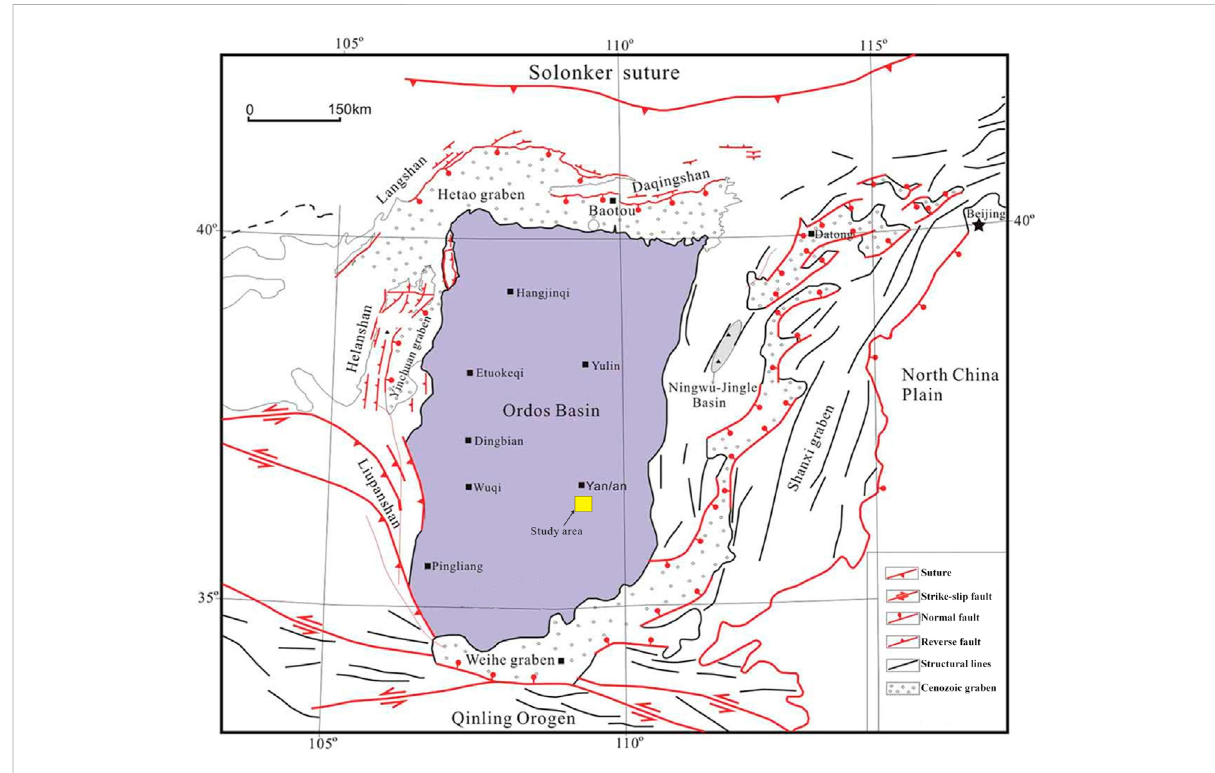
FIGURE 1 Location of the Wanhua area in the Ordos Basin (modi fi ed after Li et al.,